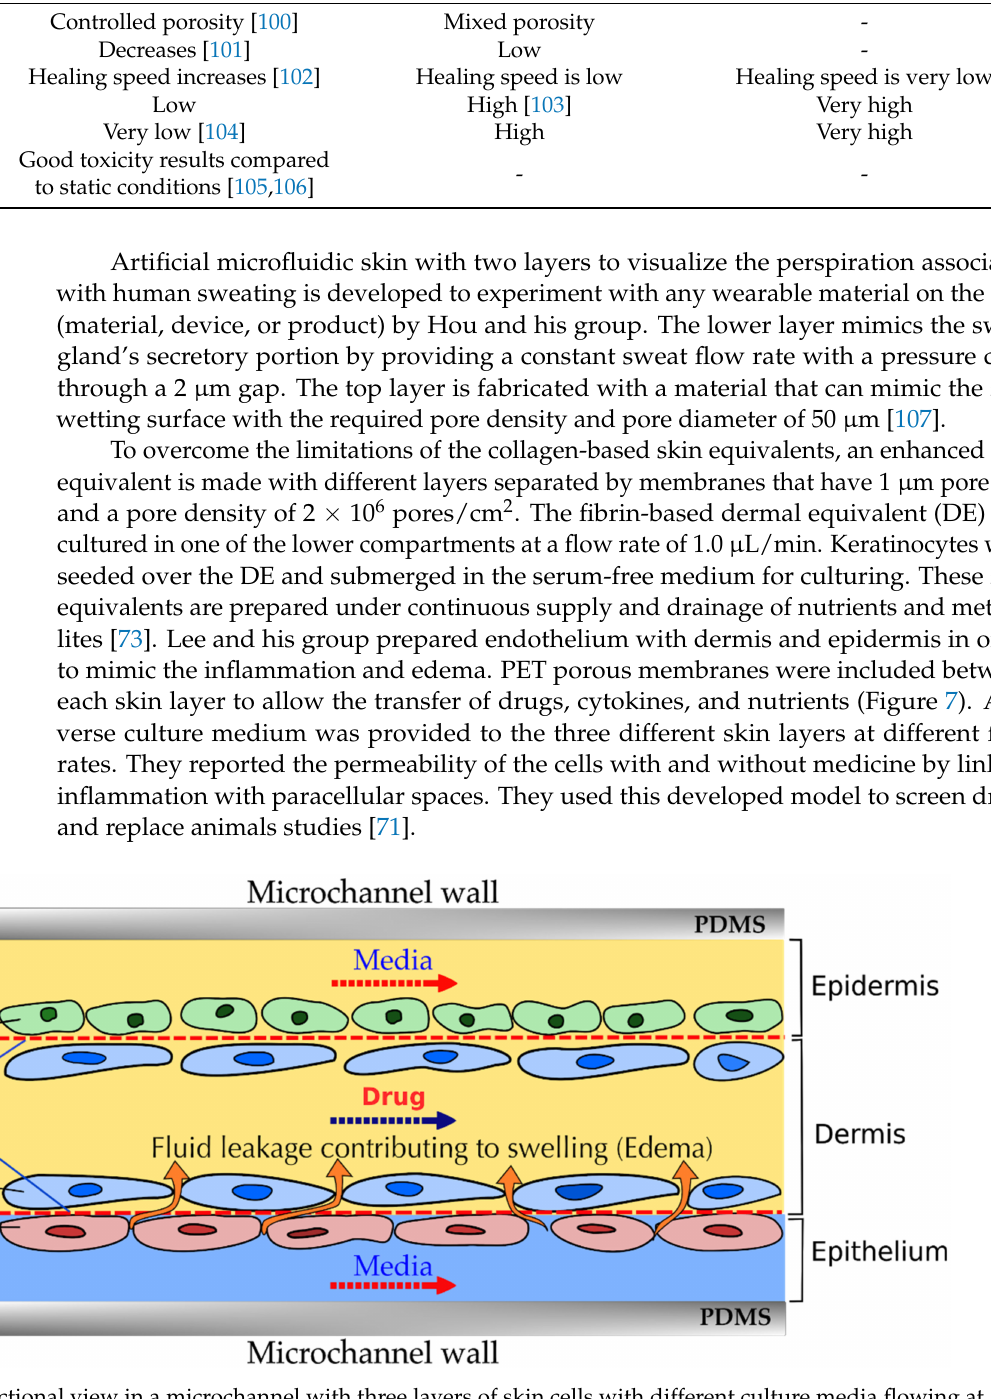
Figure 7. The cross-sectional view in a microchannel with three layers of skin cells with different culture media flowing at different flow rates to visualize inflammation, edema, and drug-based